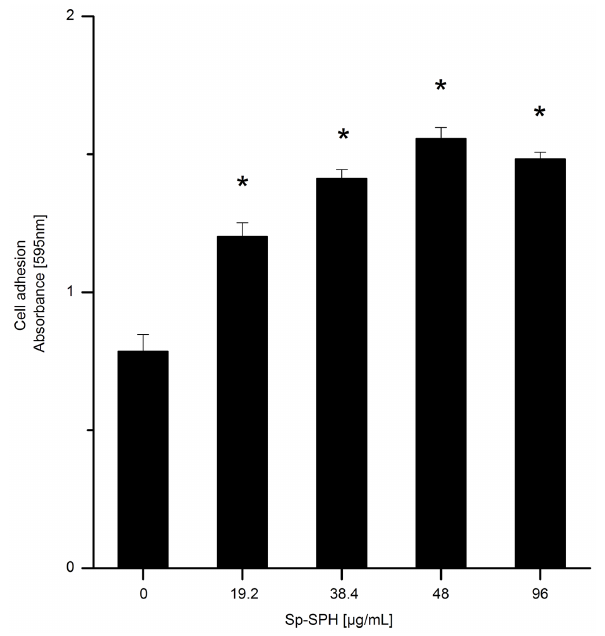
Figure 4. Determination of hemocyte adhesion activity of the mud crab mediated by Sp-SPH recombinant protein. Different concentrations of Sp-SPH recombinant protein were used for coating the ELISA plate followed by addition of crab hemocyte suspension. After washing, the cell adhesion was assessed by measuring the OD 595nm value with Multifunctional microplate reader (GENios). *: Significant differences in hemocyte adhesion of Sp-SPH protein treated samples compared to that of non-Sp-SPH protein control (paired t -test, P , 0.05). This experiment was repeated for four times. The results were shown as means 6 standards errors ( n =4).